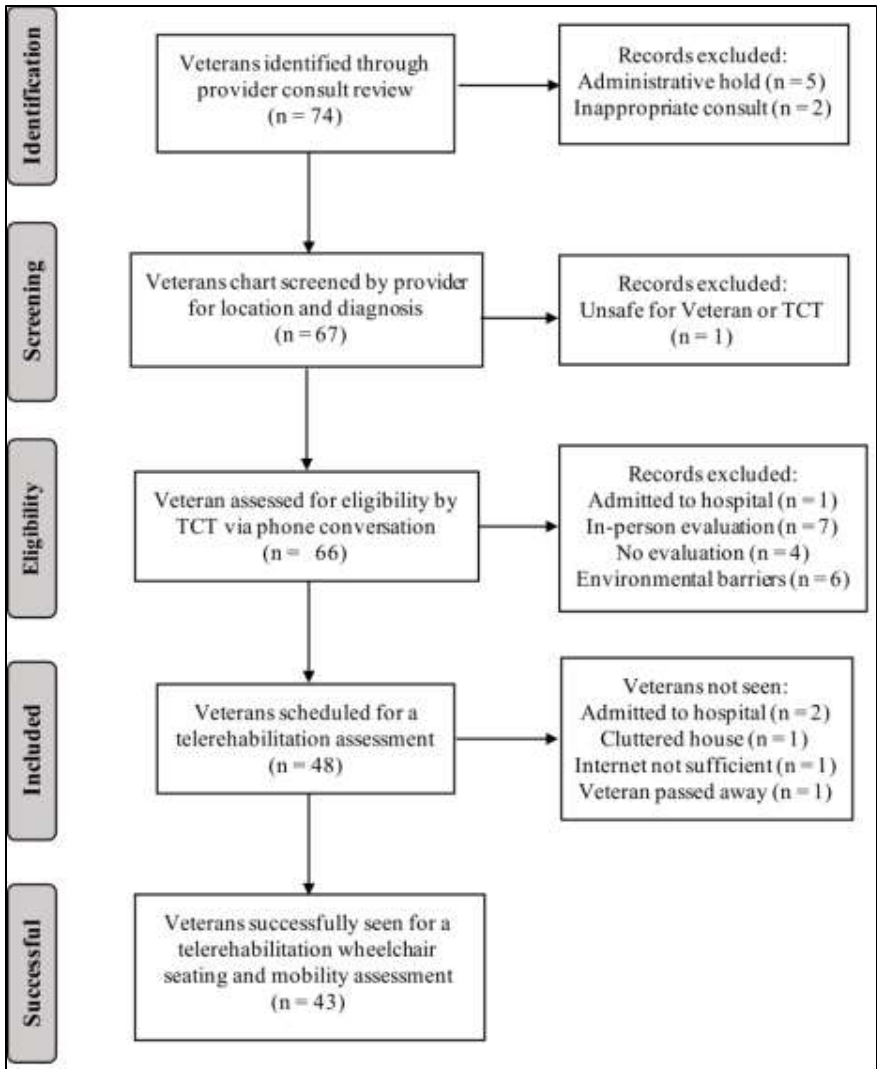
Flow Diagram for Veteran